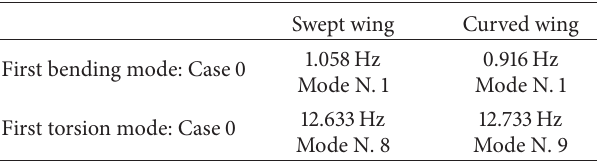
Table 4: Results of modal analysis: Case 0 (no fictitious moments of inertia were added to finite element